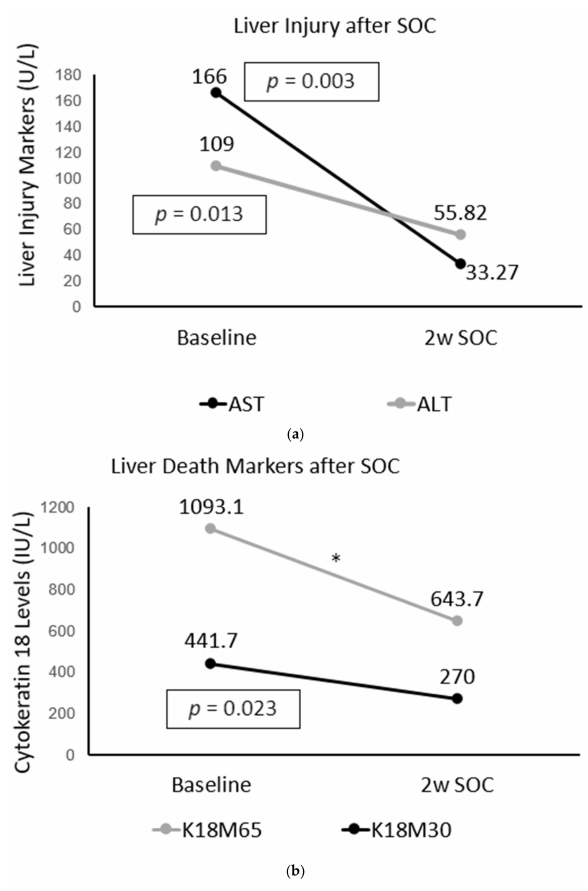
Figure 4. Liver injury and cell death markers after 2 weeks of standard of care (2w SOC). ( a ) AST and ALT after 2w SOC; ( b ) Cytokeratin K18M65 (marker of hepatocyte necrosis) and K18M30 (marker of hepatocyte apoptosis) after 2w SOC. * Not statistically